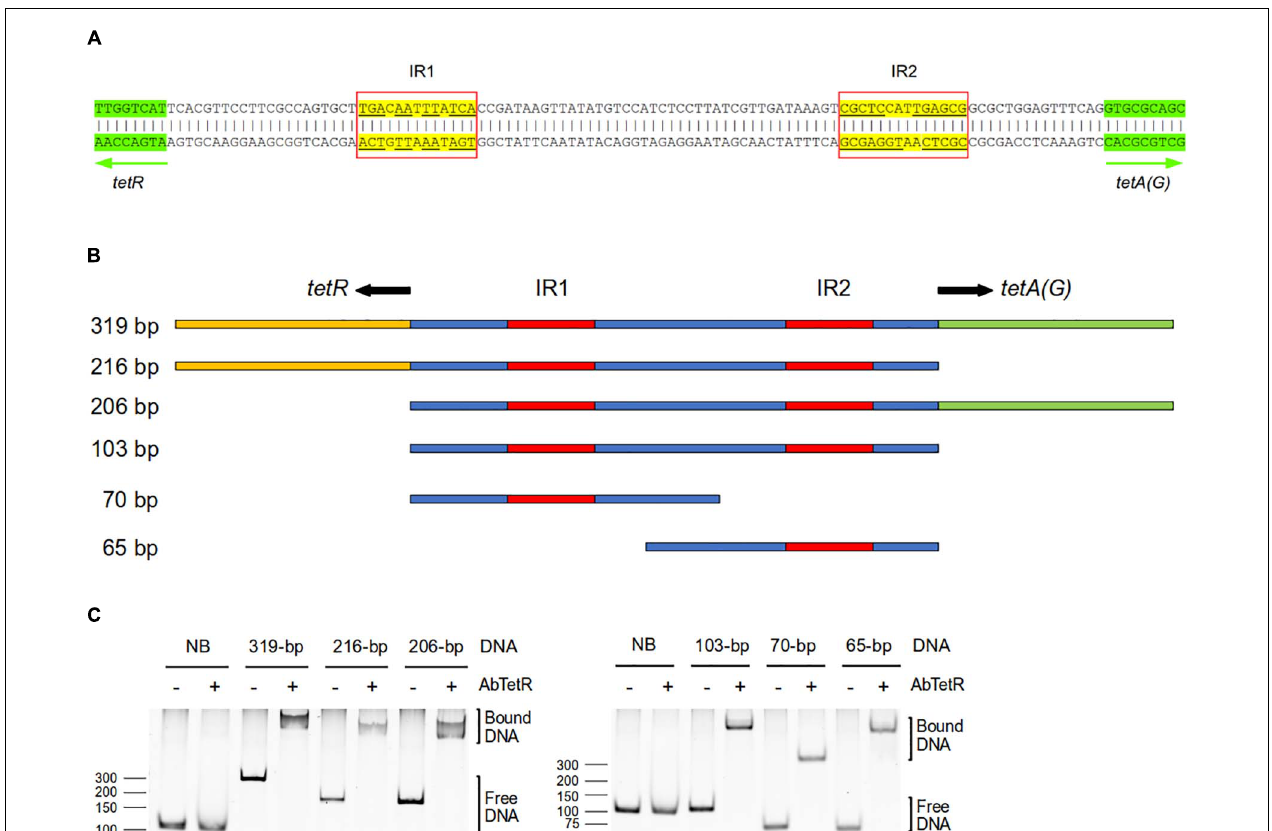
FIGURE 2 | Intercistronic region of tetR and tetA(G) . (A) The A. baumannii AYE intercistronic region of tetR - tetA(G) was analyzed for operator sequences using the EMBOSS palindromes prediction tool (Rice et al., 2000). The intergenic sequence located between tetR and tetA(G) genes contains two inverted repeat (IR) sequences, IR1 and IR2, highlighted in yellow. The divergently orientated genes tetR and tetA(G) are indicated by arrows and highlighted in green. (B) Schematic representation of the amplified dsDNA of the intercistronic region between tetR and tetA(G) genes of A. baumannii AYE. PCR products of different length consisting IR1 and/or IR2 (319–65 bp) were amplified from genomic DNA of A. baumannii AYE. The starts of the open reading frames of the tetR and tetA(G) genes are indicated in yellow and green, respectively. The intergenic region is indicated in blue and the IRs are highlighted in red. (C) Binding of dsDNA containing IR1 and/or IR2 to TetR in the electrophoretic mobility shift